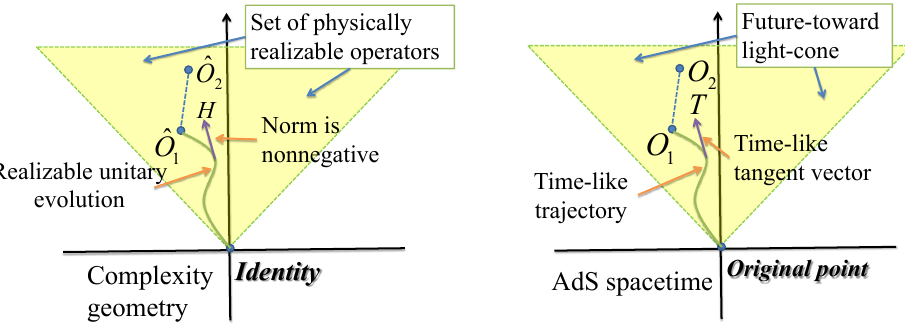
Figure 1 . Schematic diagram on the similarities between the complexity geometry of the quadratic Hamiltonian (left panel) and the spacetime geometry of AdS 3 (right panel).